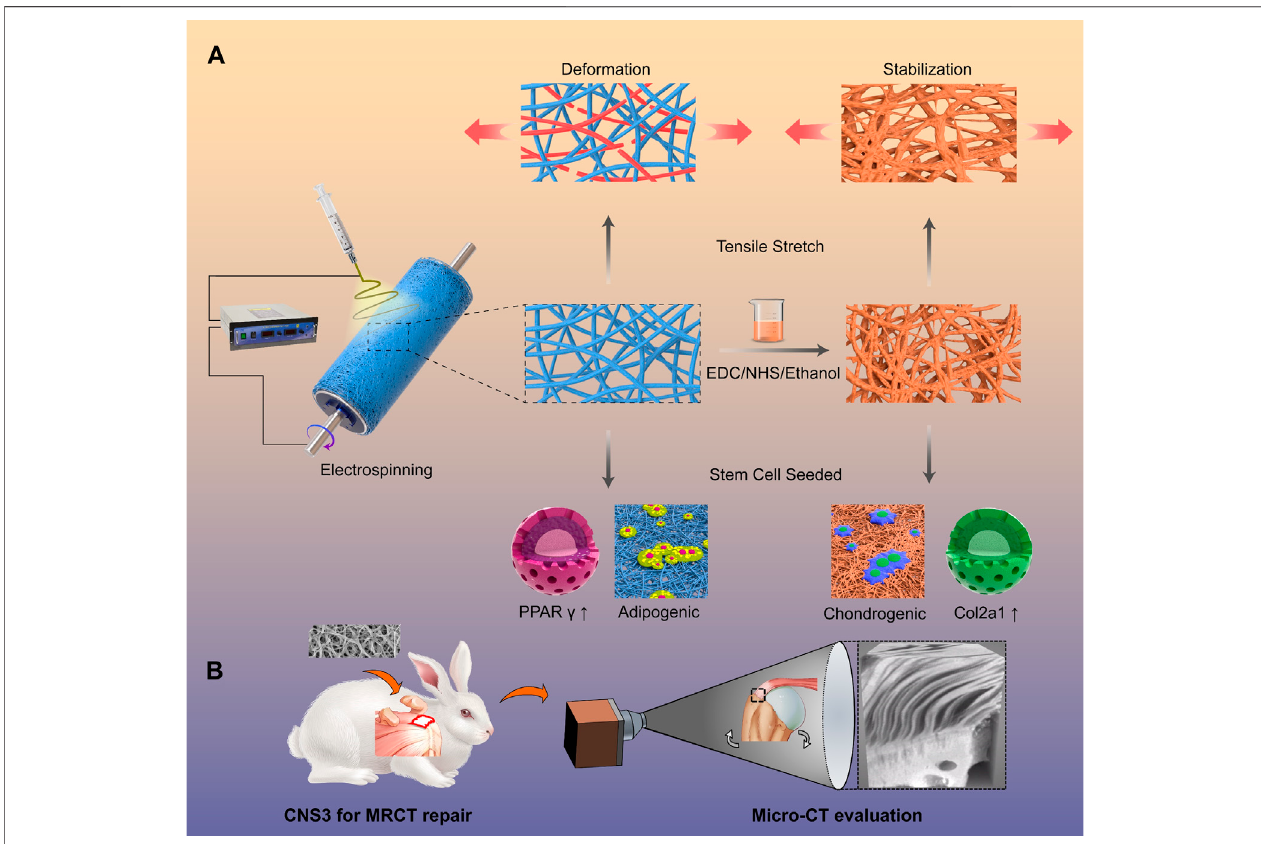
FIGURE 8 | Crimped nano fi ber scaffold mimicking tendon-to-bone interface for fatty-in fi ltrated massive rotator cuff repair. (A) Schemata of fabrication of the crimped nano fi brous scaffold for massive rotator cuff tear repairing; (B) Representative micro-computed tomography (micro-CT) images of the proximal humerus and quantitative analysis. Copyright 2022